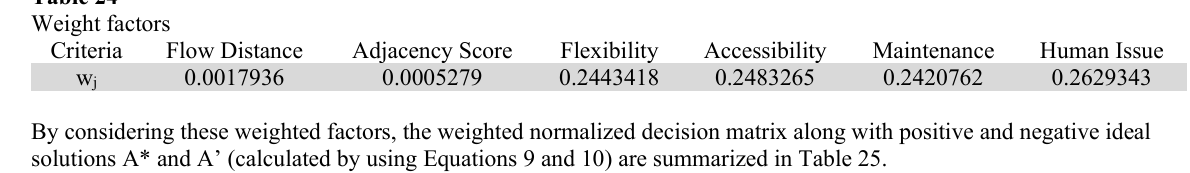
According to Table 23, entropy value (e j ) of flow distance is 0.9987357. Using Eq. (8), weight of flow distance is equal to (1 - 0.9987357) / (1 - 0.9987357) + (1 - 0.9996279) + (1- 0.8277693) + (1- 0.8249606) + (1- 0.8293663) + (1- 0.8146639)